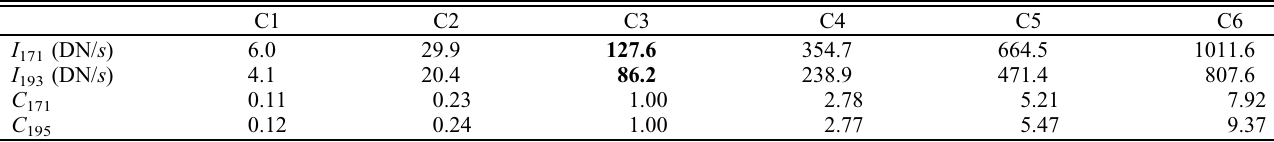
Table 2. Values for class centers. The center of Class 3 (C3, in bold) is the median of class center values obtained by SPoCA2 in the pre-study dataset. The other class centers were determined from C3 and the SOLMOD contrast values, repeated here for